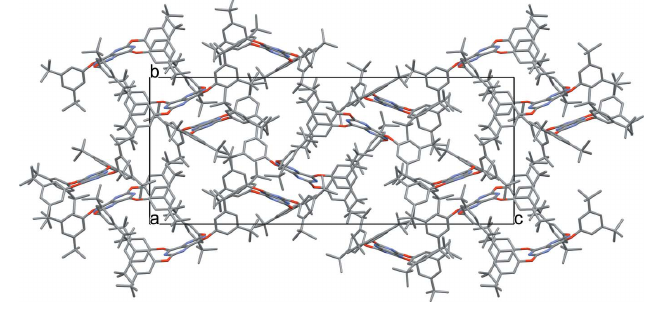
Figure 4 View of the crystal packing down the a axis.